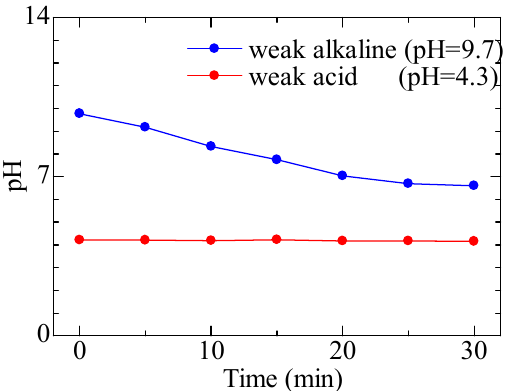
Fig. 7 Time evolution of pH during activated air microbubbling in weak alkaline or weak acid